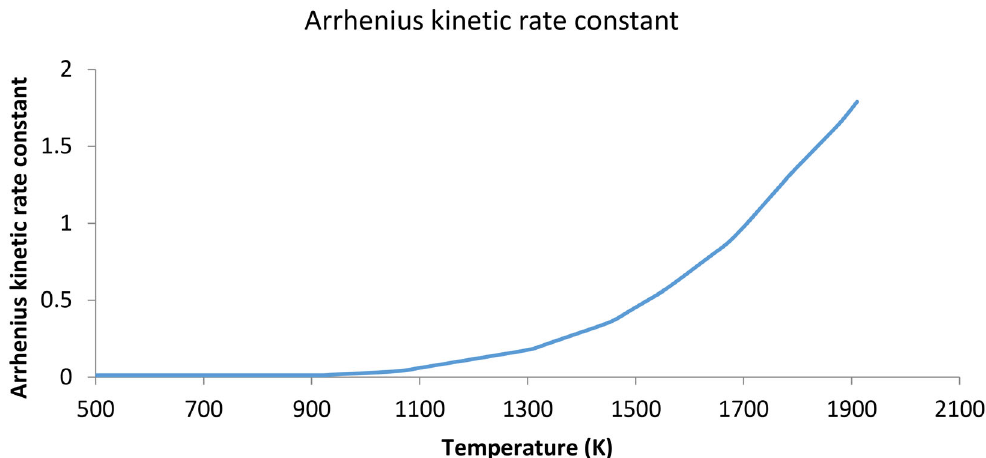
Fig. 12 Arrhenius kinetic rate constant changing for water gas shift reaction